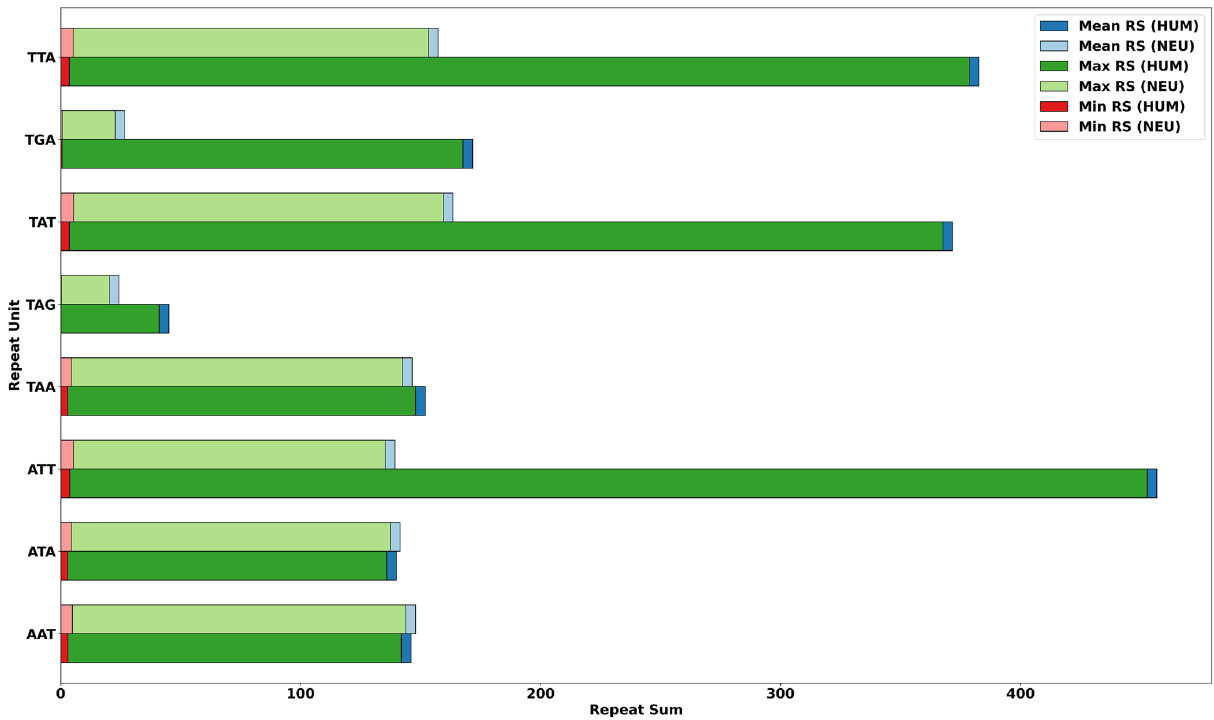
Figure 2. Mean-, max- and min- RS distribution for the RUs of